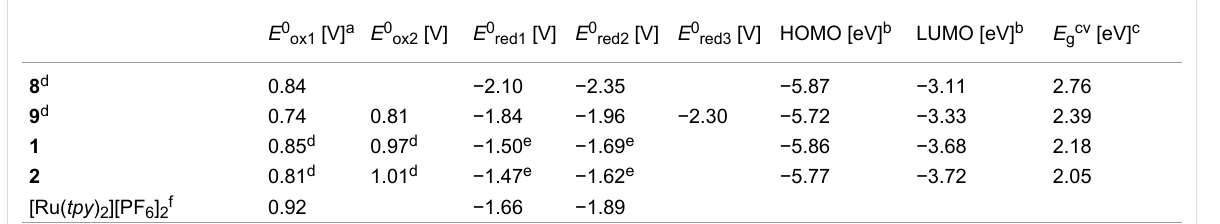
Table 2: Electrochemical properties of dendrons and dendrimers a .